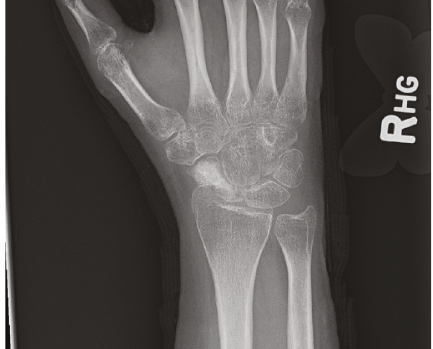
Figure 4: AP radiograph of the right wrist, demonstrating early consolidation of the autograft without evidence of local recurrence. 4-month follow-up